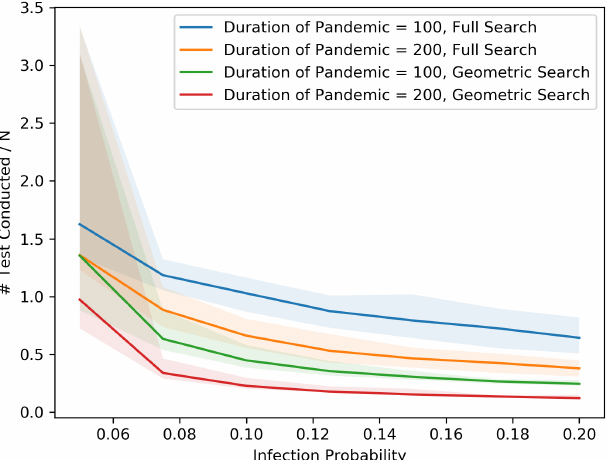
Figure 5. Number of Tests. Population = 250,000 Non-cooperative Rate = 0. N: number of people inside and containing the external boundary.